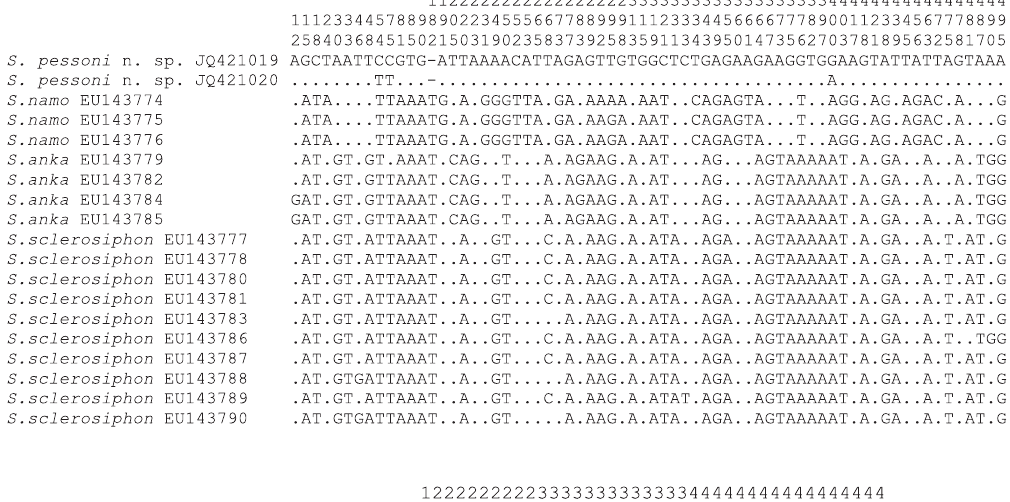
Fig. 5. – Variable positions observed within species belonging to the subgenus Vattie- romyia of Ser- gentomyia for cytochrome b sequences.